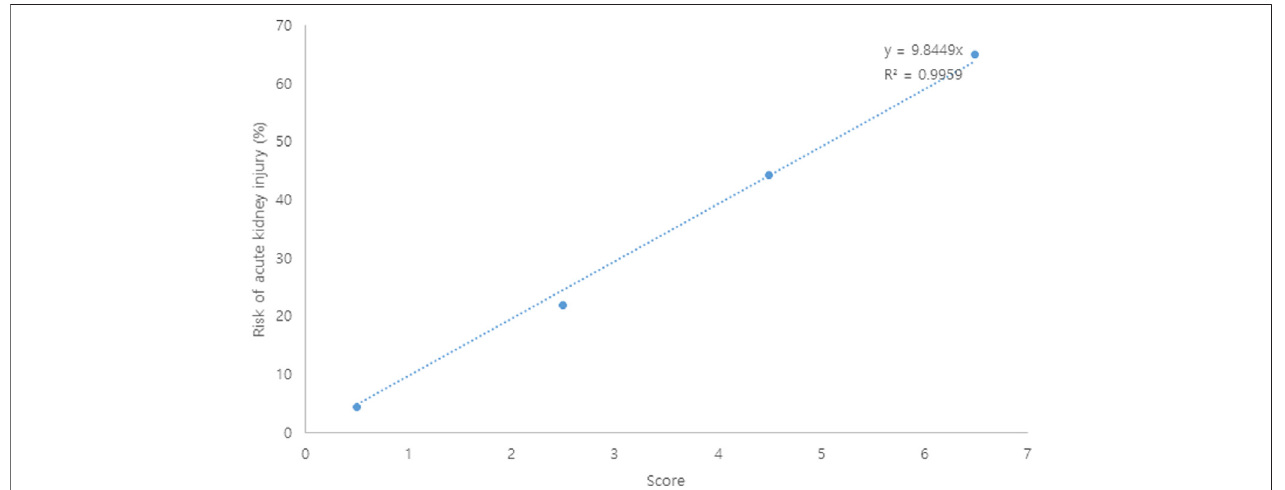
FIGURE 1 | Risk (%) of vancomycin-associated acute kidney injury according to